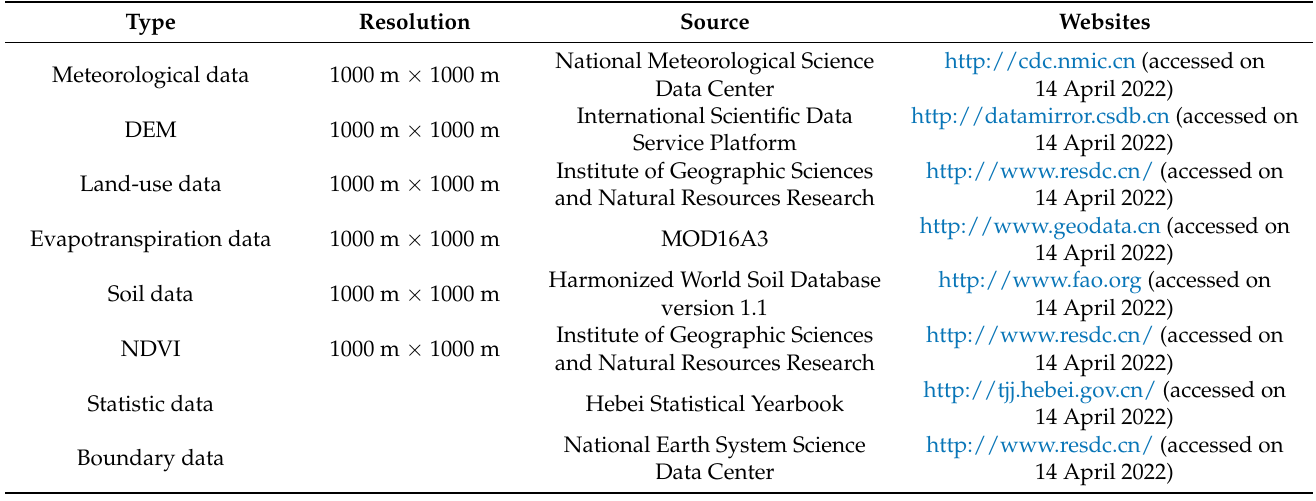
Table 1. Data and their source.